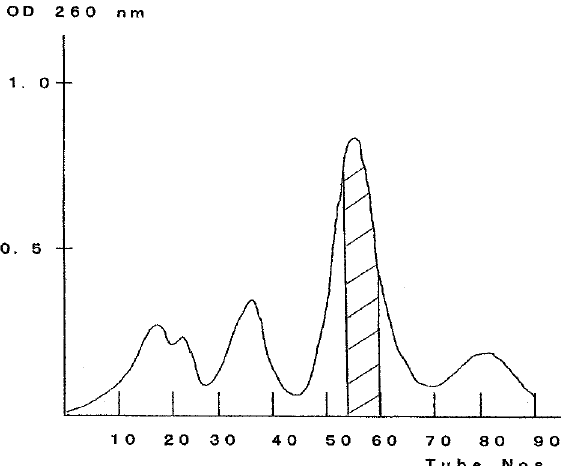
FIG. 2. Purification of synthetic [l-Nal 3 ]-TP-II by ion-exchange chromatography on a CM-Biogel A column.